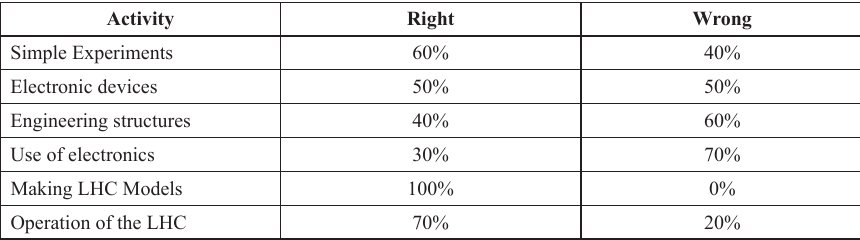
Table 2. Shows the “Particle Accelerators and Detectors” field observations